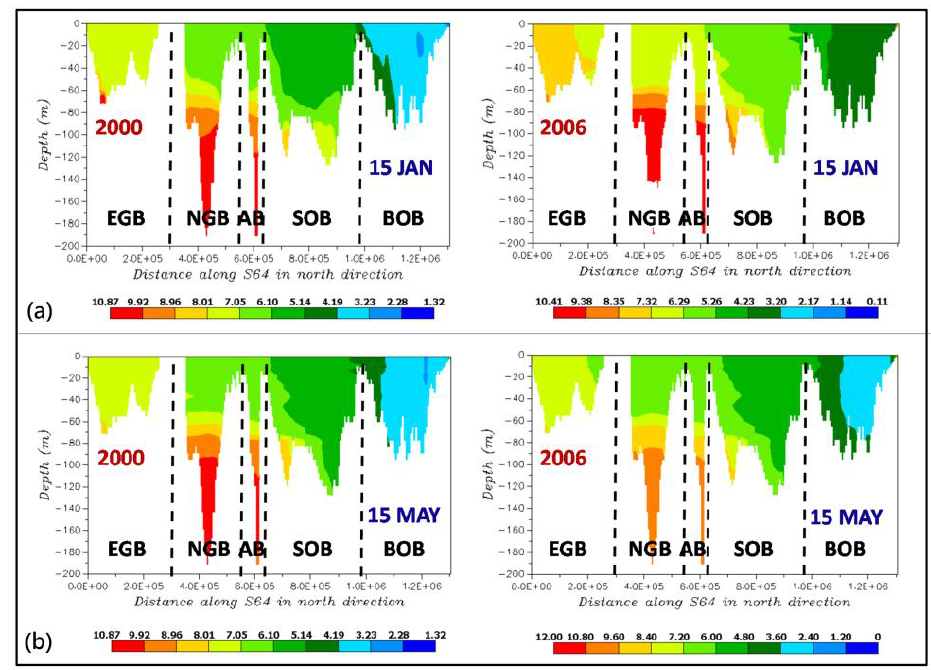
Figure 17. ( a ) Winter salinity stratification in the Baltic Sea at cross section S64 for the years 2000 and 2006; ( b ) Spring salinity stratification in the Baltic Sea at cross section S64 for the years 2000 and 2006.